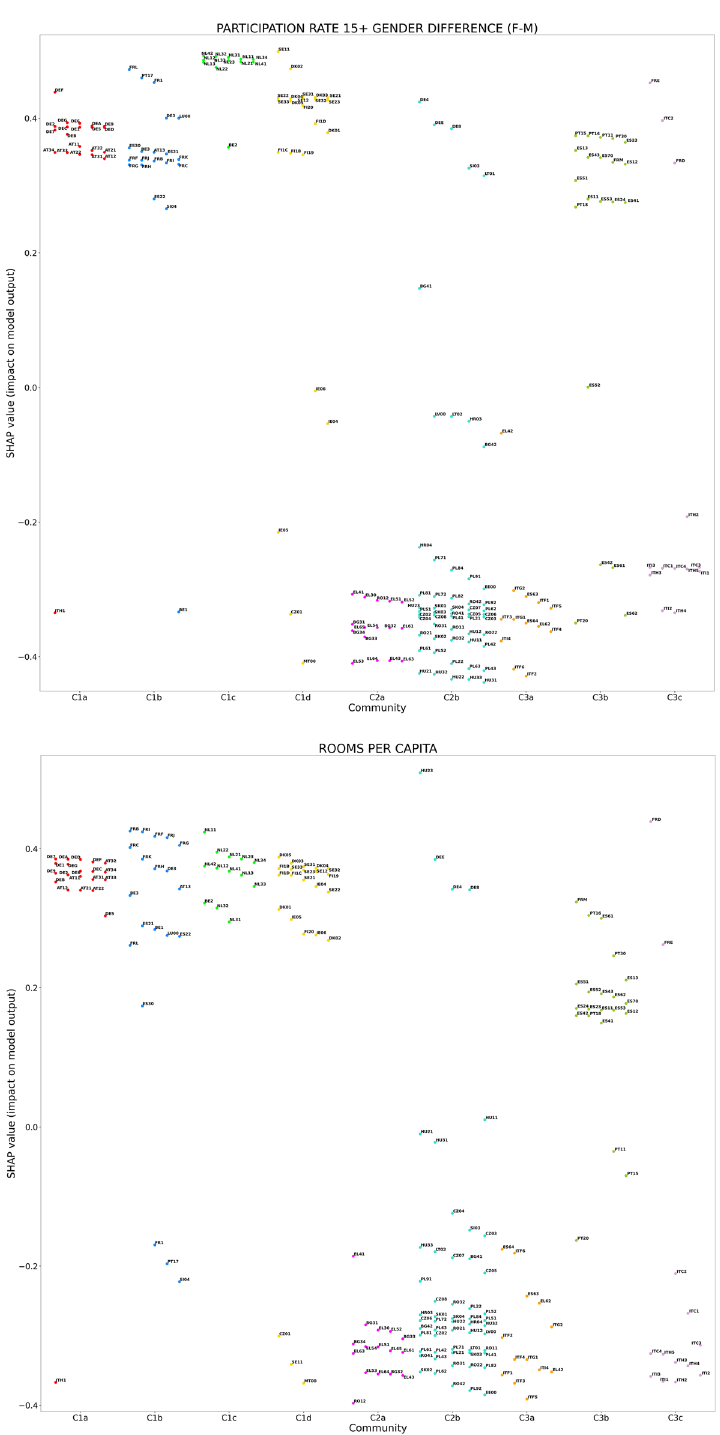
Figure 7. Distributions in the subregion network communities (reported on the horizontal axes) of the SHAP values related to the two indicators that show the highest impact, in terms of mean absolute SHAP value, on the prediction of EQI scores. In both cases, the distributions are characterized by R > 1 with respect to the network partition, highlighting the tendency of indicators to have similar SHAP values in regions belonging to the same community and relevant differences across